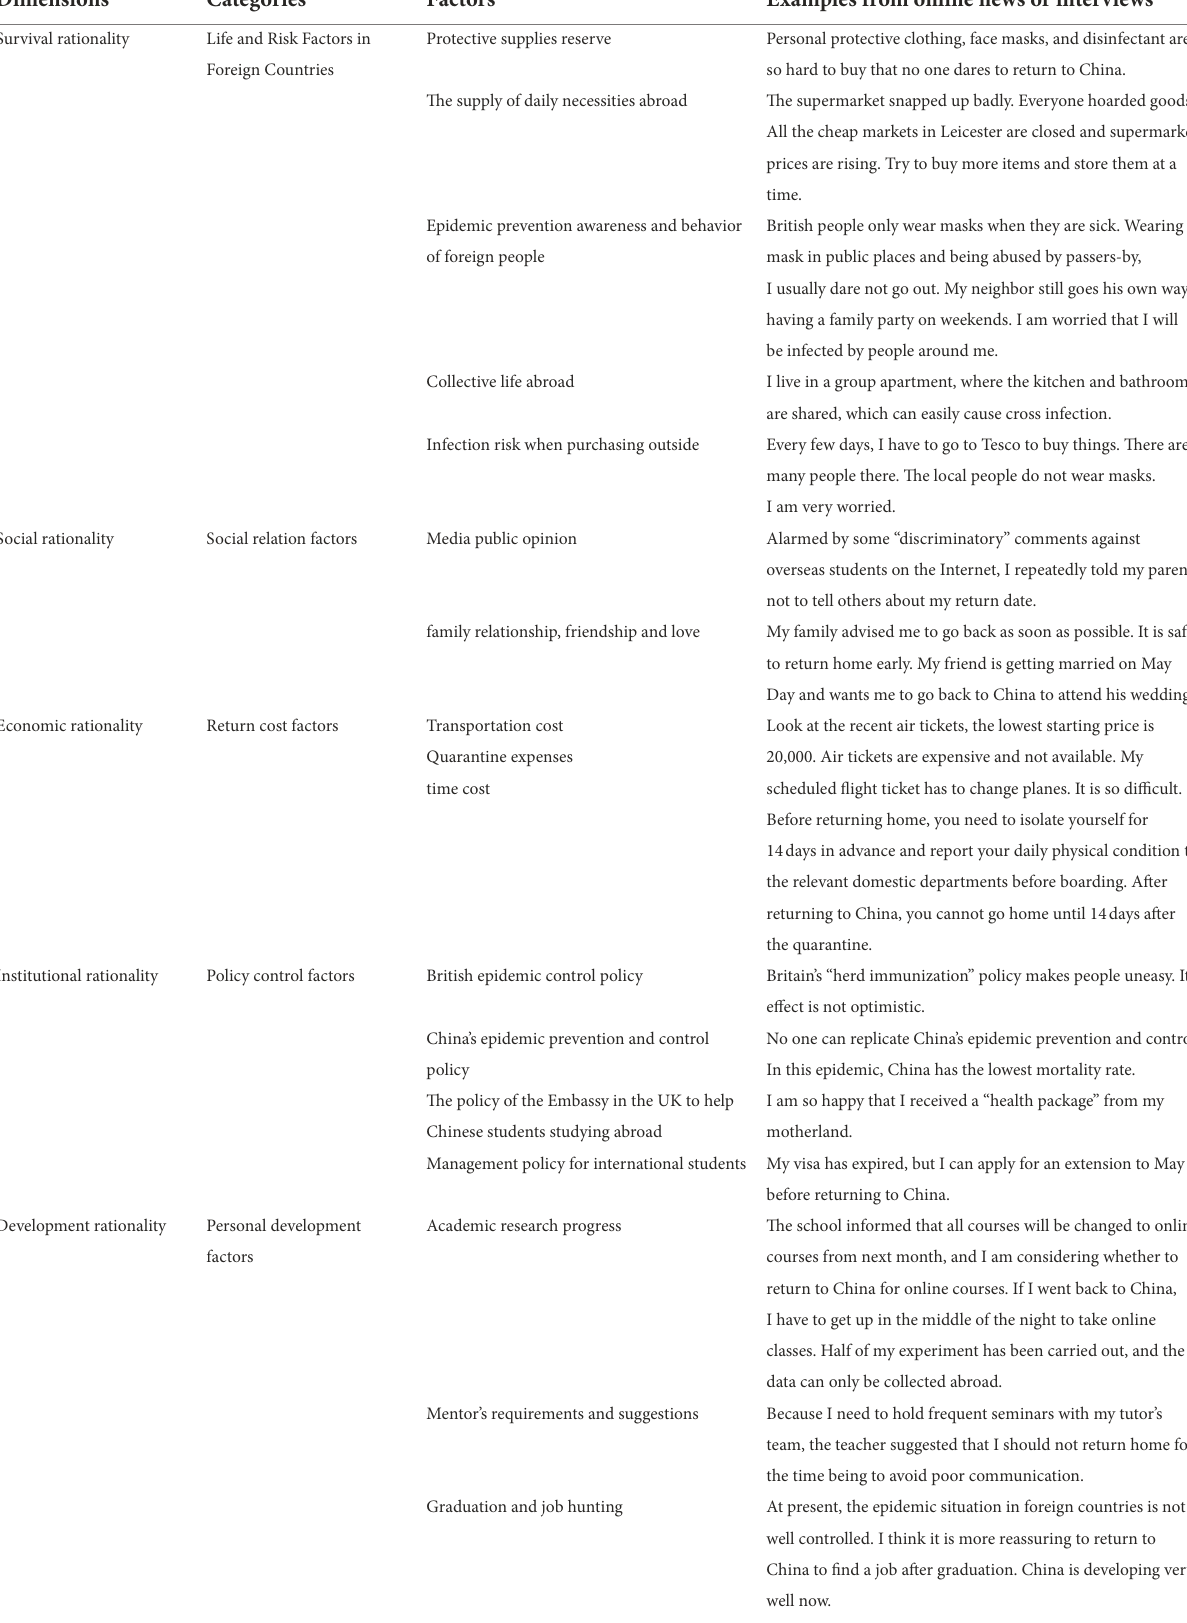
TABLE 2 Coding results of influencing factors of overseas students returning